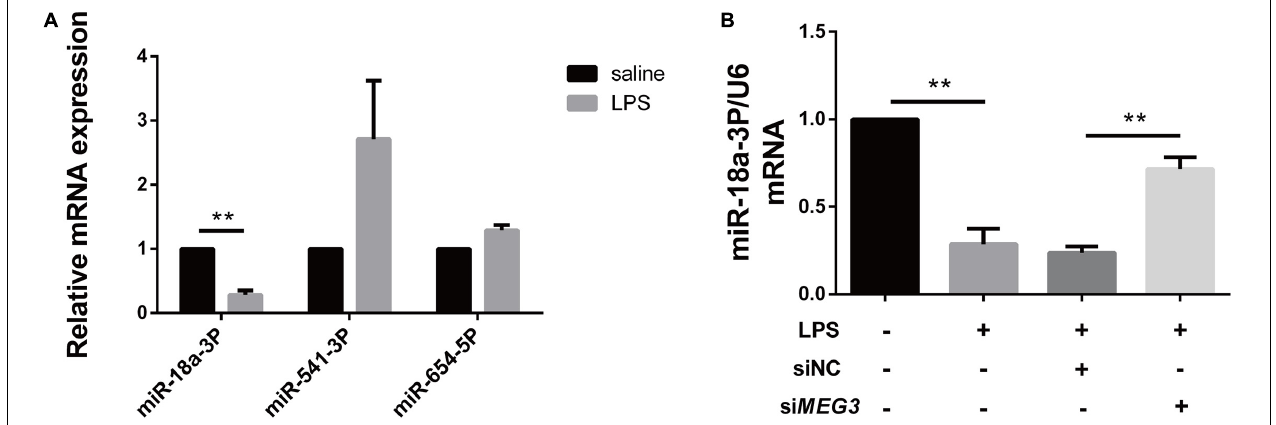
FIGURE 4 | miR-18a-3P is decreased in LPS-AKI. (A) Expression levels of miRNA in renal tissues of LPS-AKI mice (40 mg/kg). (B) Expression levels of miR-18a-3p in siRNA-transfected TECs. ** P < 0.01, compared with the respective control